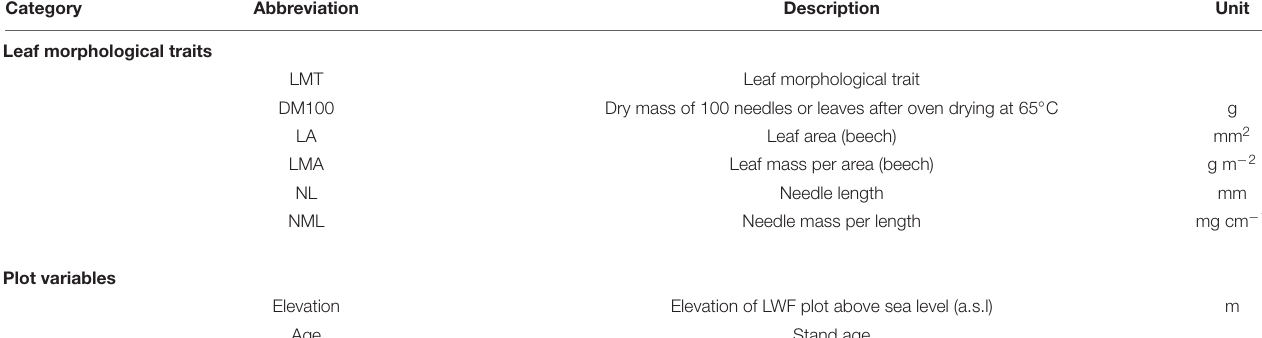
TABLE 2 | List of abbreviations and variable